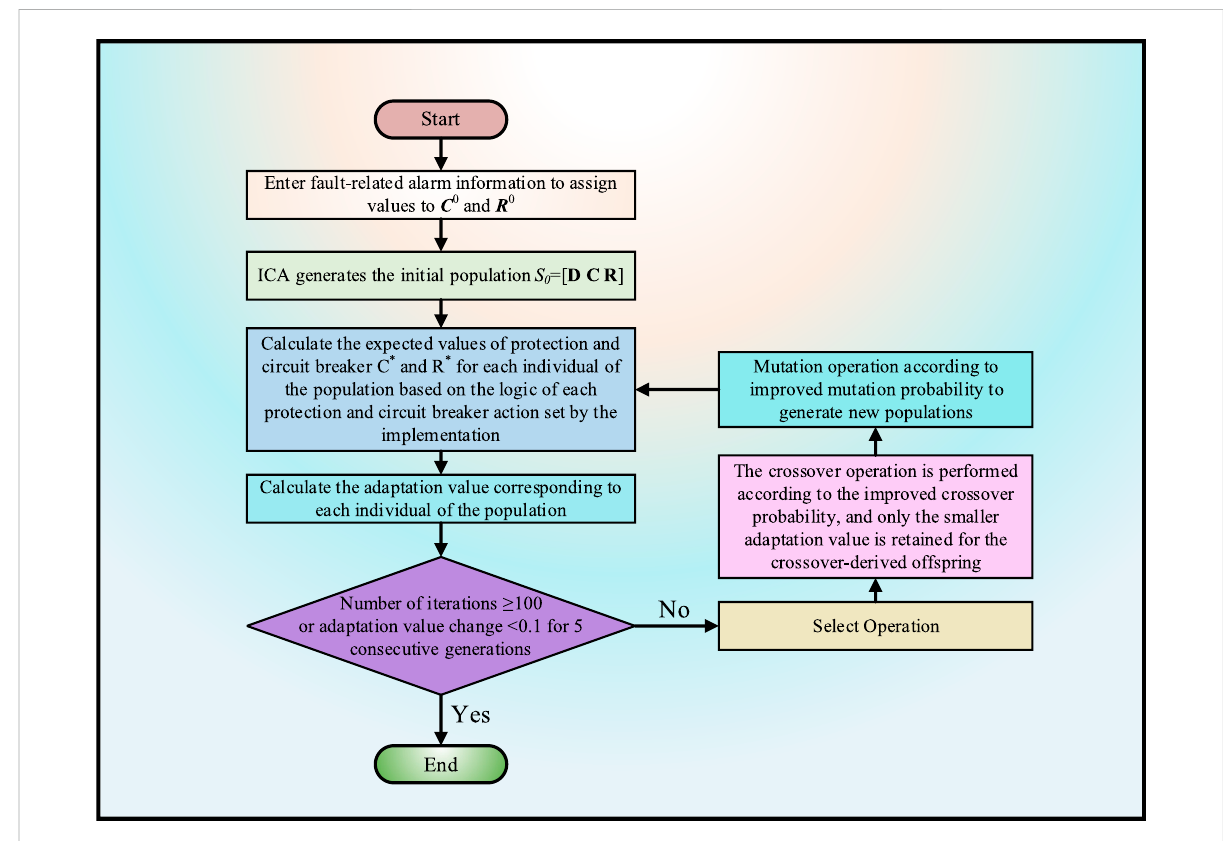
FIGURE 3 Flow chart of substation fault identi fi cation algorithm based on improved genetic